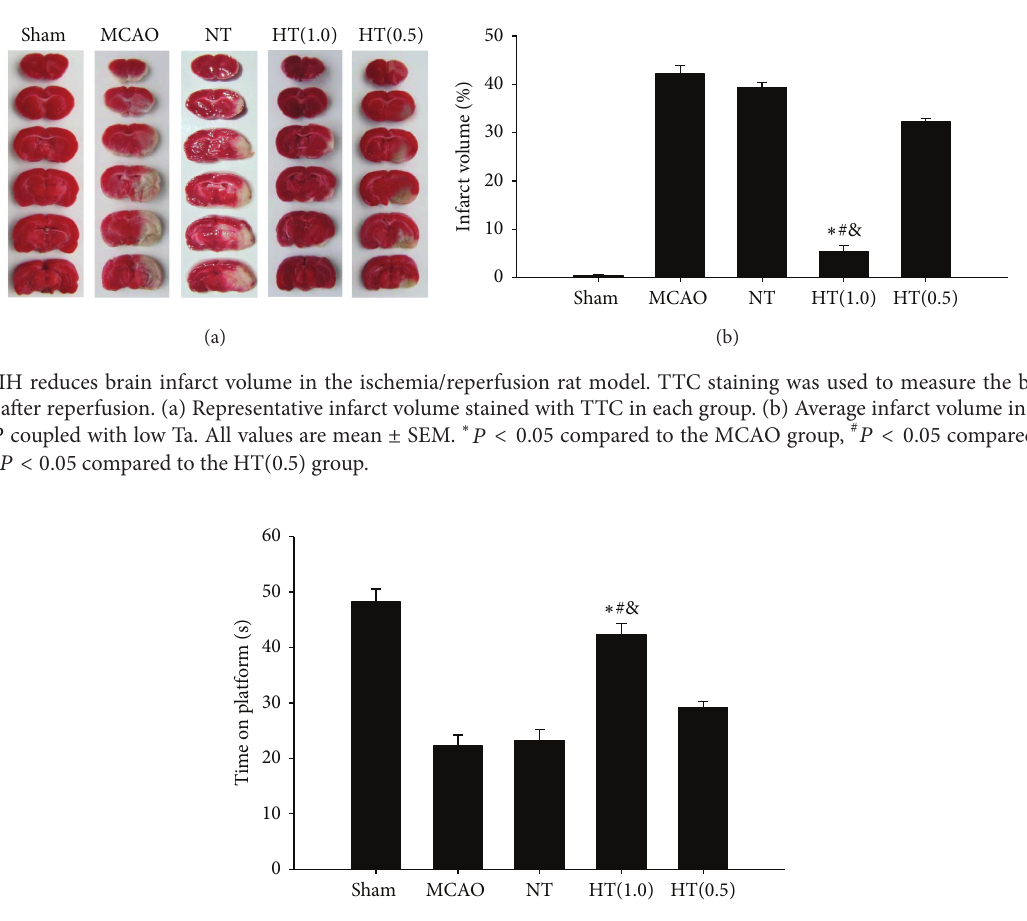
Figure 3: AIH improves neurological function after brain ischemic injury. The neurological function of rats after ischemic injury was evaluated using the rotarod test. All values are mean ± SEM. ∗ 𝑃 < 0.05 compared to the MCAO group, # 𝑃 < 0.05 compared to the NT group, and & 𝑃 < 0.05 compared to the HT(0.5)